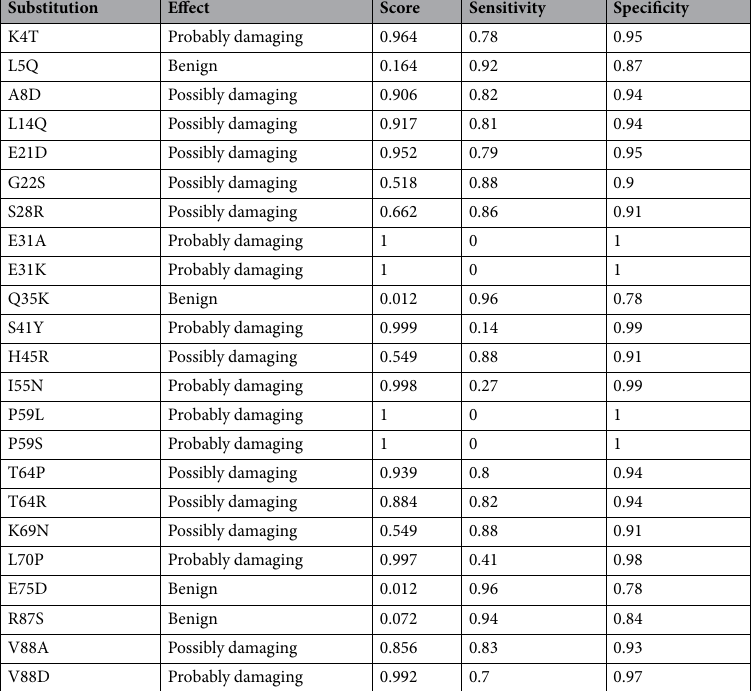
Table 3. Structural homology-based prediction of damaging coding nsSNPs using PolyPhen-2.